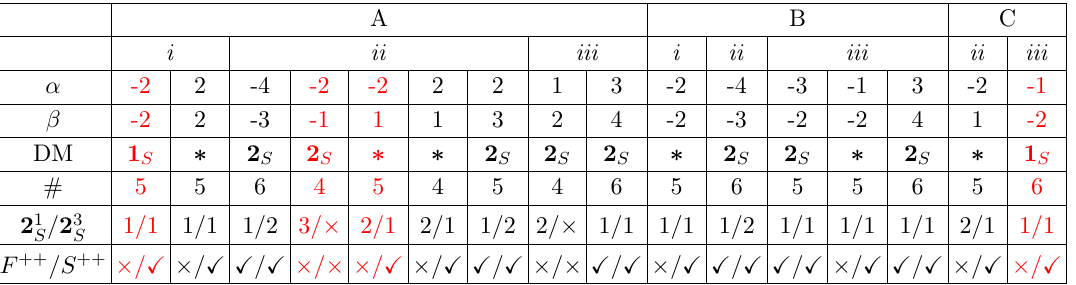
Table 20. The same as in table 19 for diagram